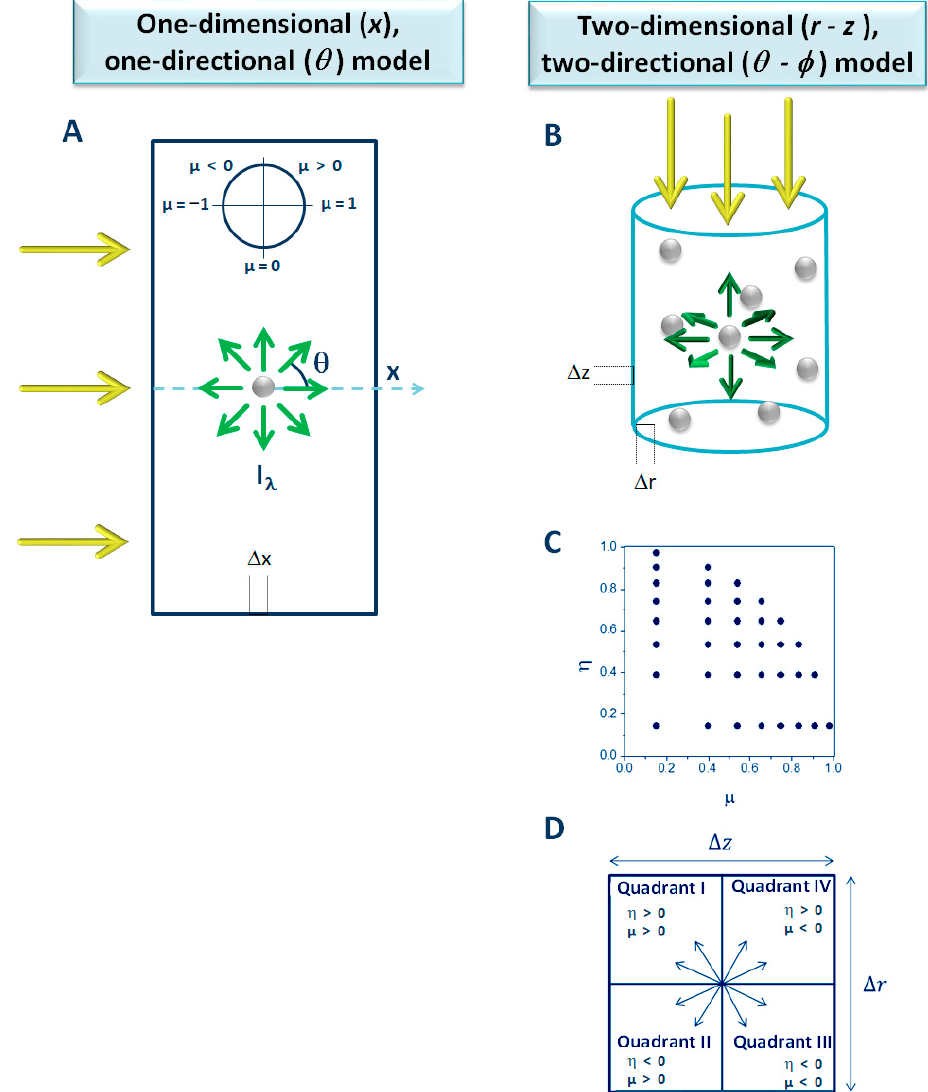
Figure 11. Spectrophotometric cell and one-dimensional, one-directional radiation model ( A ). Reactor vessel and two-dimensional, two-directional radiation model ( B – D ). The directional mess for quadrant I and the representation of the quadrants (at each spatial point) are presented in panels ( C , D ), respectively.